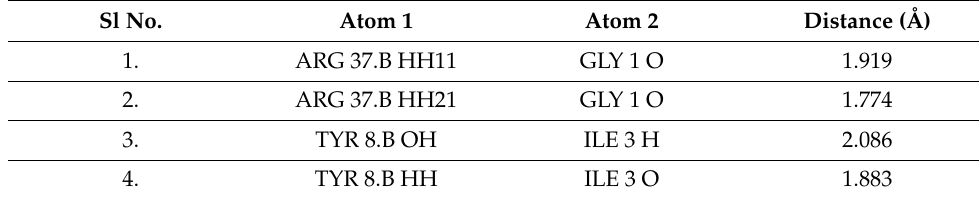
Table 8. Details of H bonds between ternary structure and T cell epitope. Sl